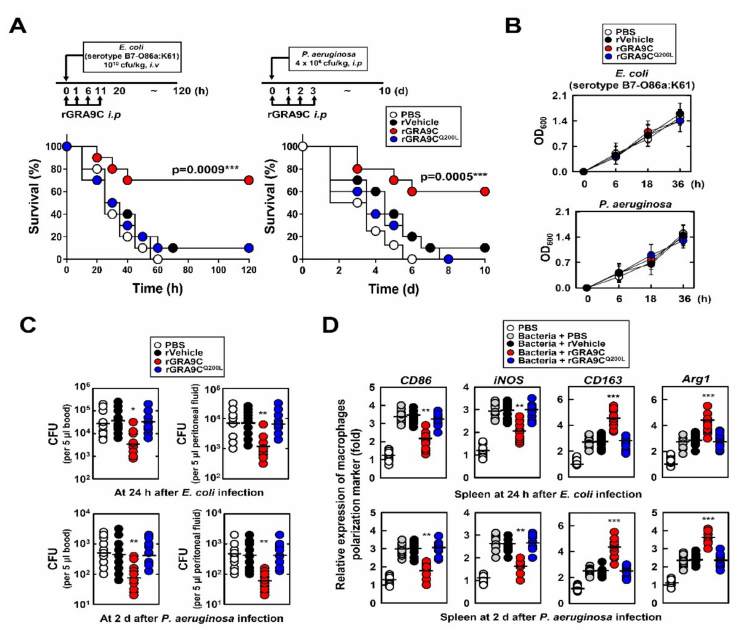
Figure 7. rGRA9C prevents mice from E. coli or P. aeruginosa -induced septic shock. ( A ) Schematic of the bacteria infection model treated with PBS, rVehicle, rGRA9, or rGRA9C Q200L (upper). The survival of mice was monitored for 10 days; mortality was measured for n = 10 mice per group (lower). Statistical di ff erences compared to the rVector-treated mice are indicated (log-rank test). The data are representative of two independent experiments with similar results. ( B ) Bacteria were cultured in LB broth contained in presence of PBS, rVector, rGRA9 or rGRA9C Q200L (50 µ g / mL) for the indicated times at 37 ◦ C Measure the OD 600 every 6 h. Data shown are the means ± SD of three experiments. ( C ) The bacterial burden was evaluated after 24 h or 2d in bacteria infected mice with PBS, rVehicle, rGRA9C or rGRA9C Q200L ( n = 10 mice per group). ( D ) Splenocytes were used for quantitative real-time PCR with M1 (CD86 and iNOS) or M2 (CD163 or Arg1) macrophage polarization marker. ( A , C , D ) Significant di ff erences (* p < 0.05; ** p < 0.01; *** p < 0.001) compared with rVector-treated